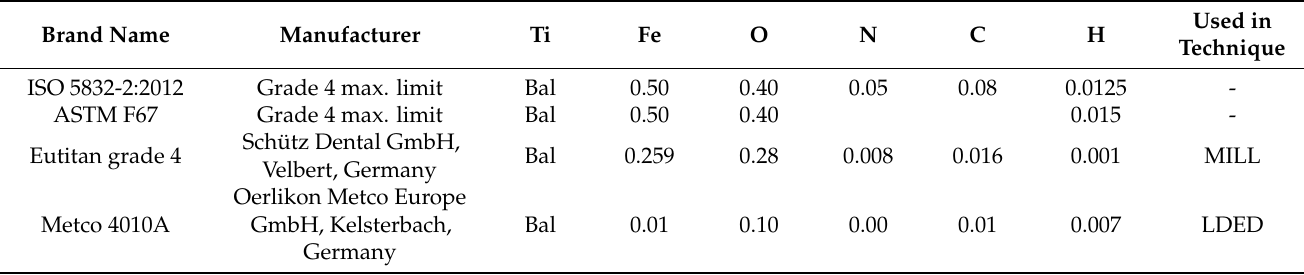
Table 1. Chemical composition (wt %) of the alloys tested in the present study with standards limitations for grade 4 titanium. Data provided by the